Question: Write a caption explaining this figure to a reader.
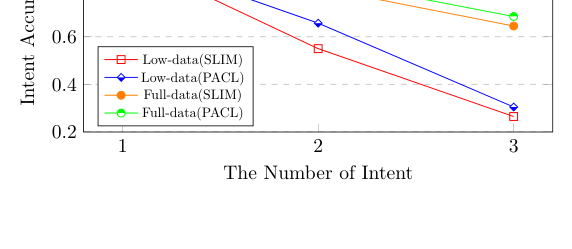
Answer: The Intent Accuracy of different numbers of intents trained on low- and high-data of MixATIS dataset.